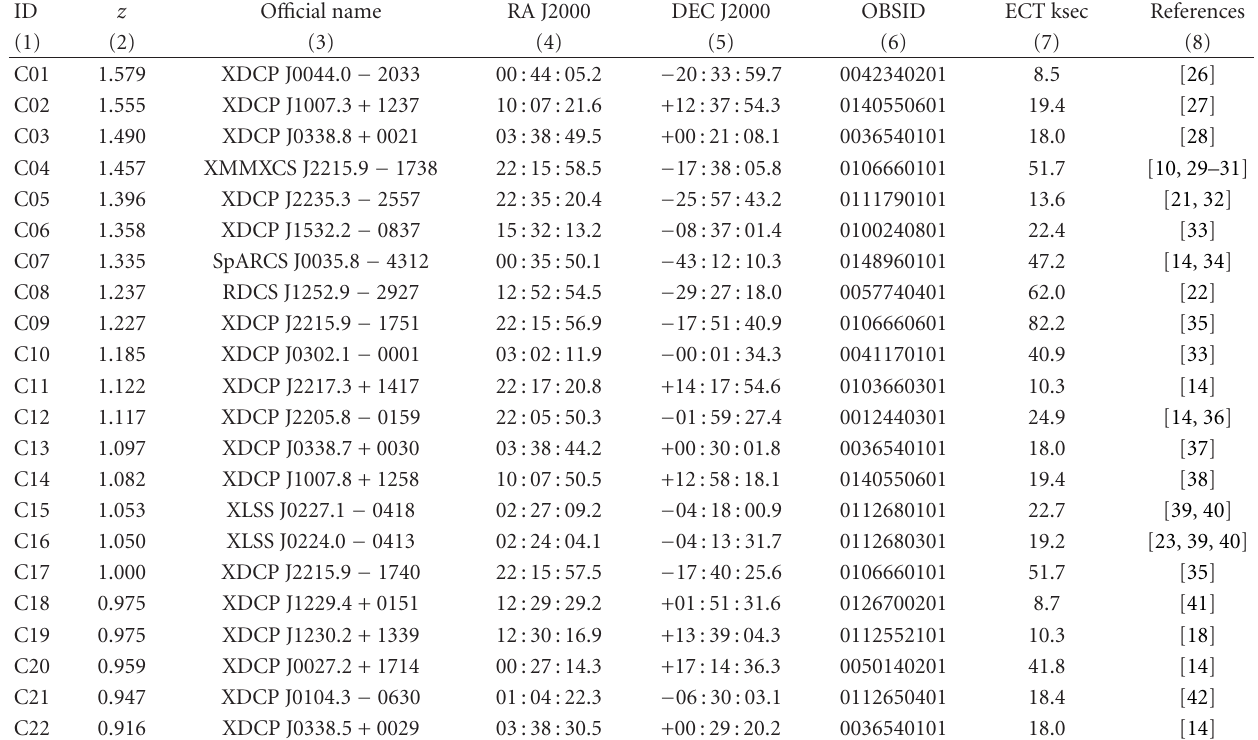
Table 1: List of the 22 distant galaxy clusters at z > 0 . 9 from Fassbender et al. [14] used for the stacking analysis in this work. The table lists a cluster identification number (column 1), the system redshift (2), the o ffi cial cluster name (3), X-ray centroid coordinates (4 + 5), the observation identification number of the XMM- Newton field used (6), the corresponding e ff ective clean time (ECT) of the field in (7), and relevant literature references to the cluster in